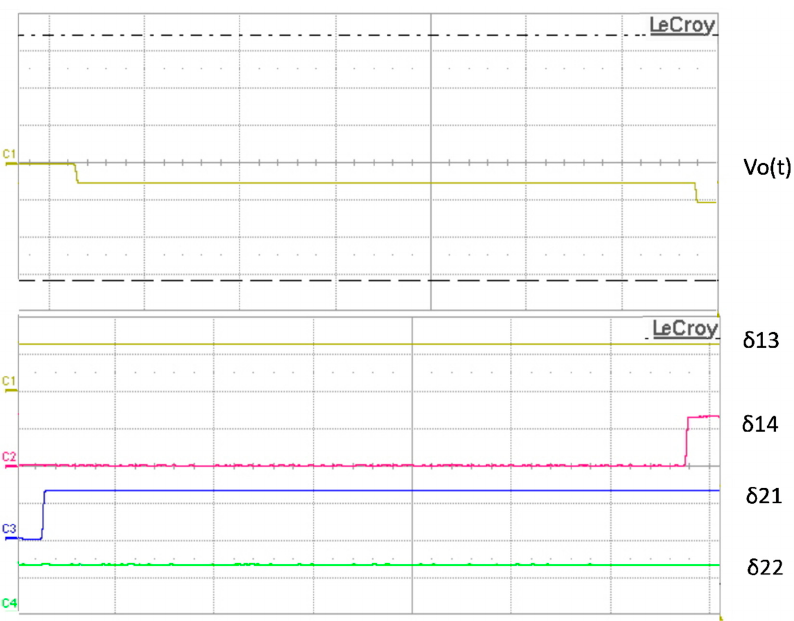
Figure 24. Output voltage V o (t) and switching patterns sent to T11, T12, T23, and T24 (ZOOM 1 of Figure 23).